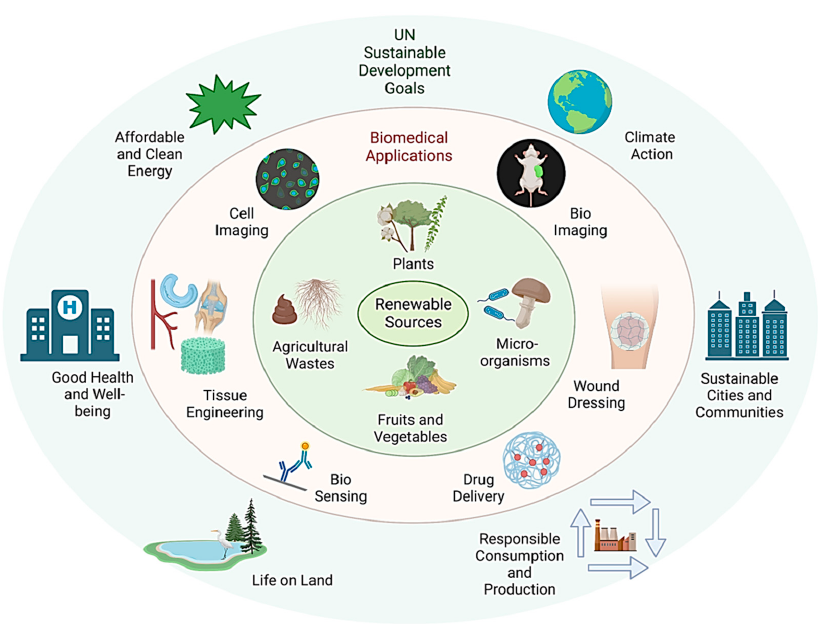
Figure 1. Renewable resources to design sustainable nanomaterials and their biomedical applications for a sustainable future. Sustainable nanotechnology encompasses the safe manufacturing of sustainable na-